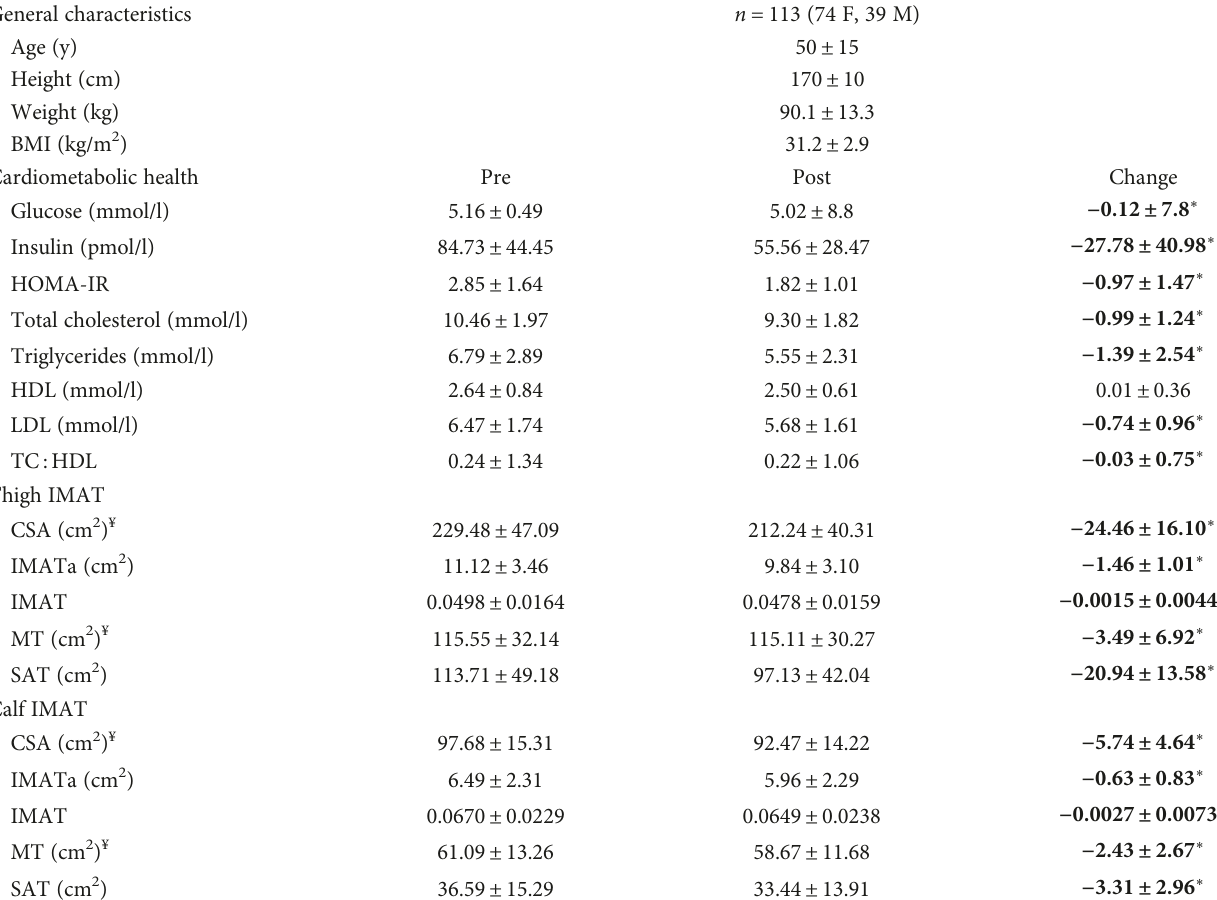
Table 2: Clinical and cardiometabolic characteristics of all